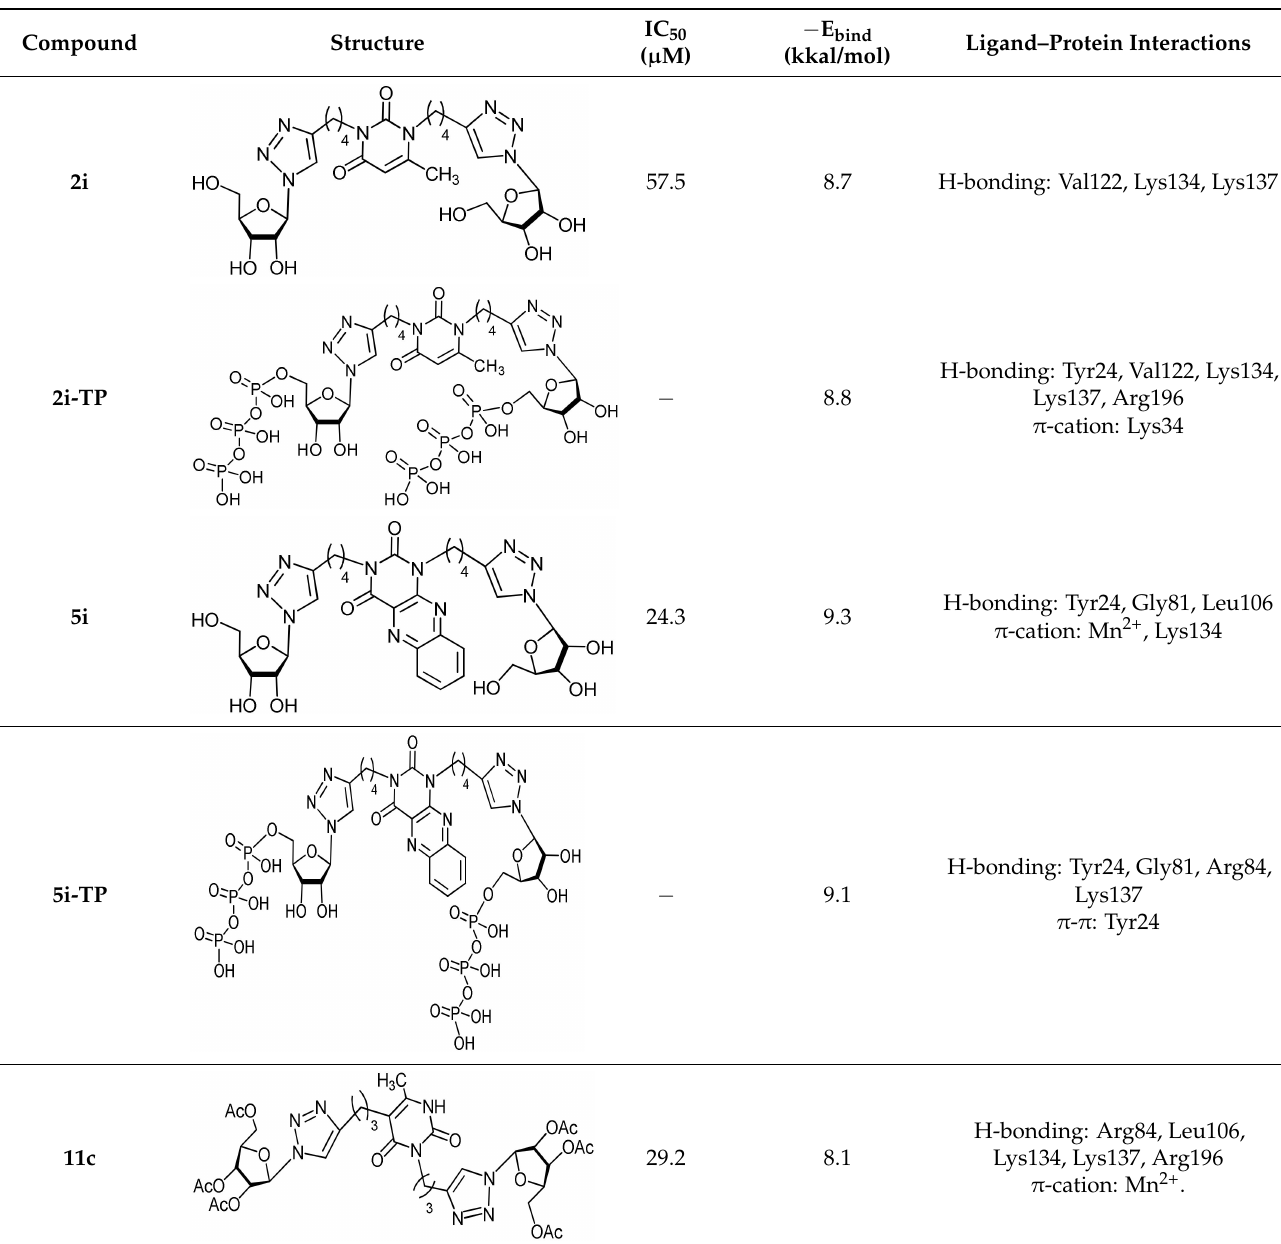
Table 4. Inhibitory activity against influenza virus A H1N1 of the lead compounds as well as their binding energies and ligand–protein interactions obtained by molecular docking